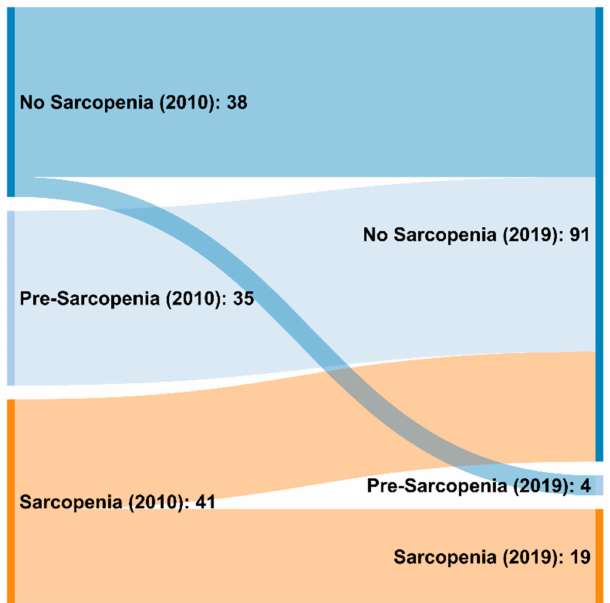
Figure 1. Sankey diagram to visualize and quantify the changes in sarcopenia diagnosis using the EWGSOP 2010 and 2019 criteria.